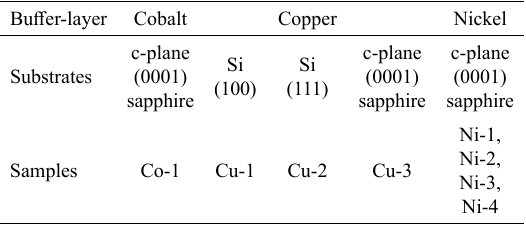
Table 1. Samples produced using different substrates and buffer-layers.